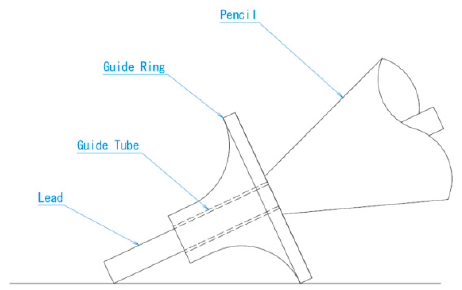
Figure 3. Pencil lead break test.